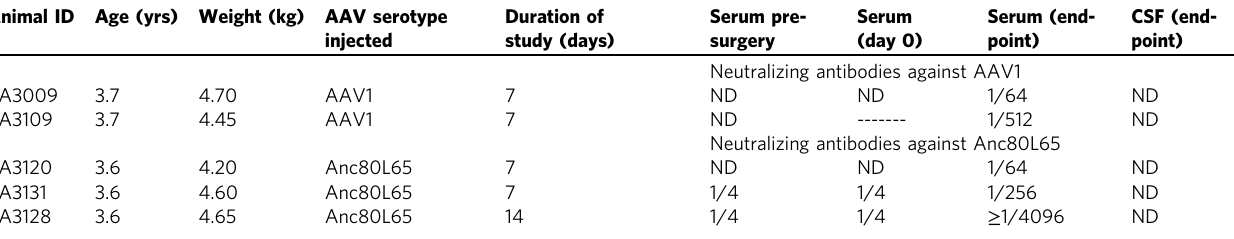
Table 1 Experimental design and neutralizing antibody titers detected in serum and cerebrospinal fl uid. Animal ID Age (yrs) Weight (kg) AAV serotype